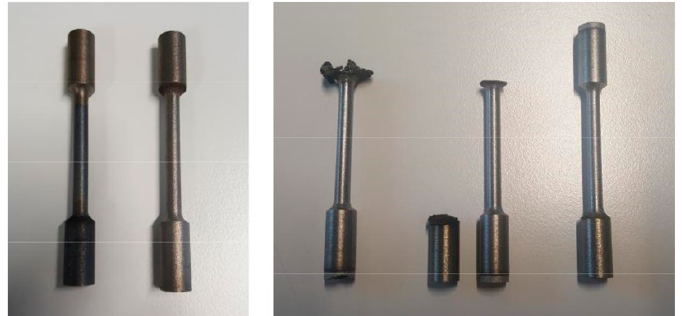
Figure 29. Tall parts produced by selected companies: company A ( left ), company G ( right ).